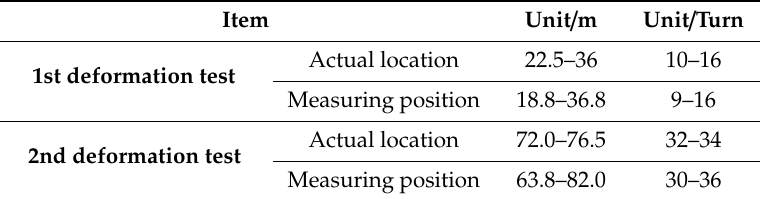
Table 4. Comparison of deformation test